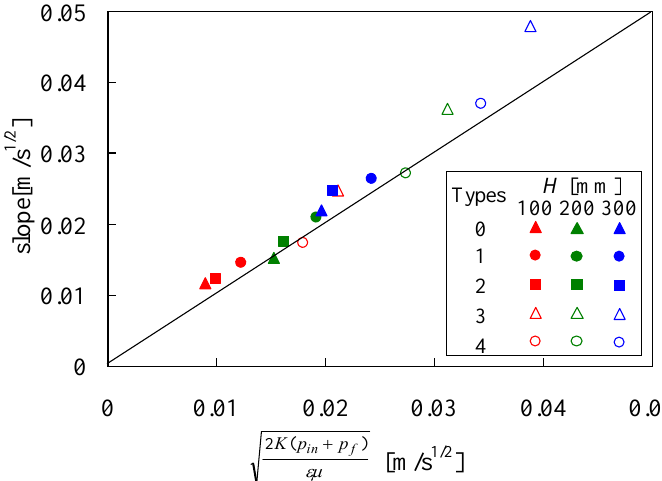
Fig. 8 Comparison between the slopes of plots in Fig. 6 and the coefficients of t 1/2 in Eq. 4. These values are in good agreement each other. The slope, which is related to the speed of wetting, can be estimated by the parameters of microstructures such as permeability K , capillary pressure p or porosity  . f